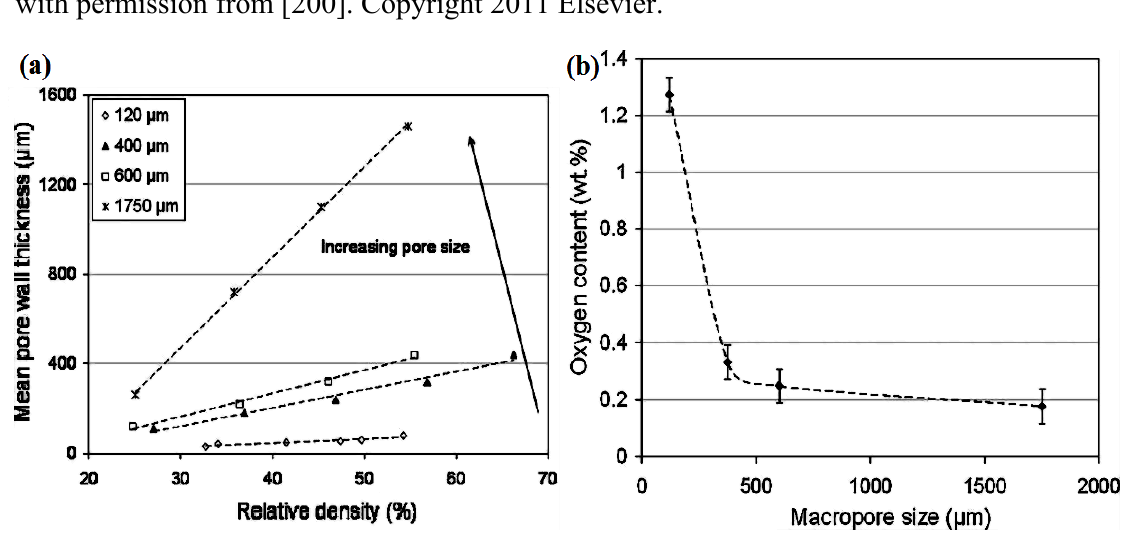
Figure 16. ( a ) Mean pore wall thickness values of the porous titanium material produced with different size spacers at various relative densities; ( b ) Oxygen content of porous titanium material with 25% relative density and varying macropore size [200]. Reprinted with permission from [200]. Copyright 2011